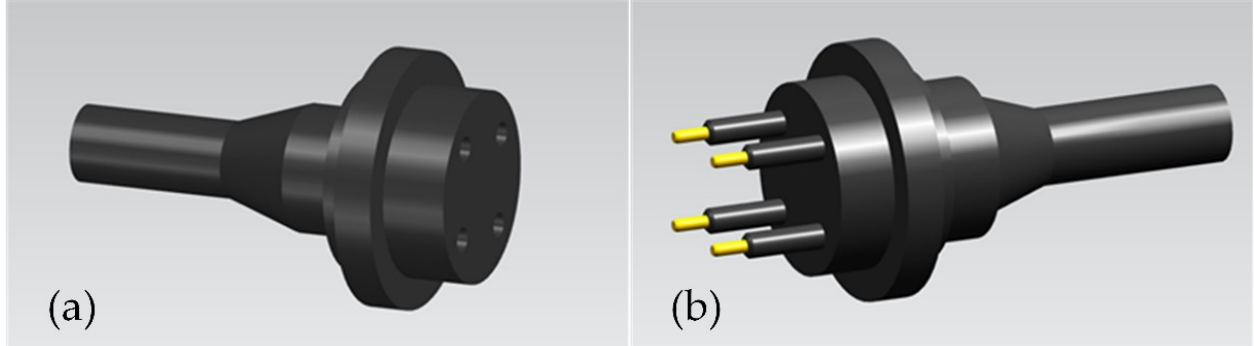
Figure 1. A basic 3D CAD view of an underwater electrical connector: ( a ) receptacle and ( b ) plug.